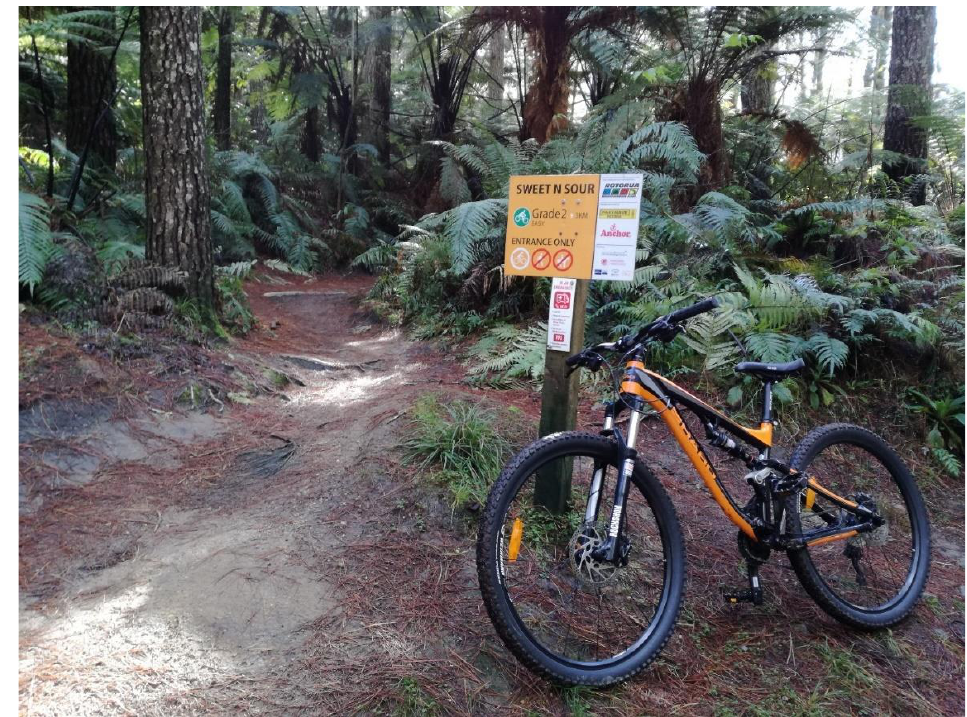
Figure 1. Mountain bike single track in planted production forest in Rotorua, New Zealand.